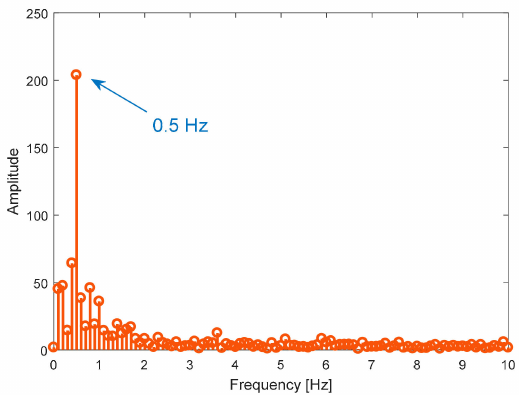
Figure 8. Spectral analysis of detected movement in Figure